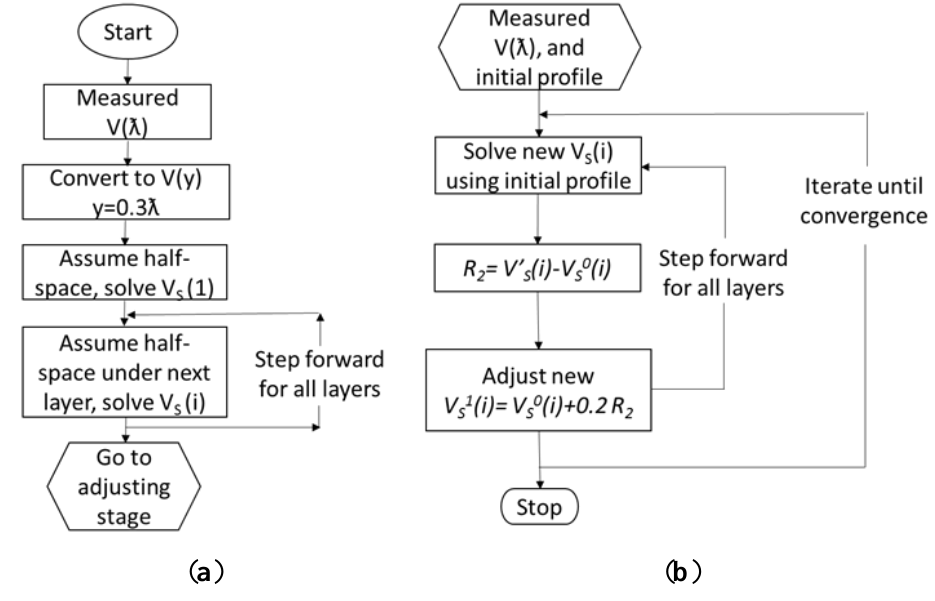
Figure 7. Flowchart of fast inversion analysis; ( a ) Initializing stage; and ( b ) Adjusting